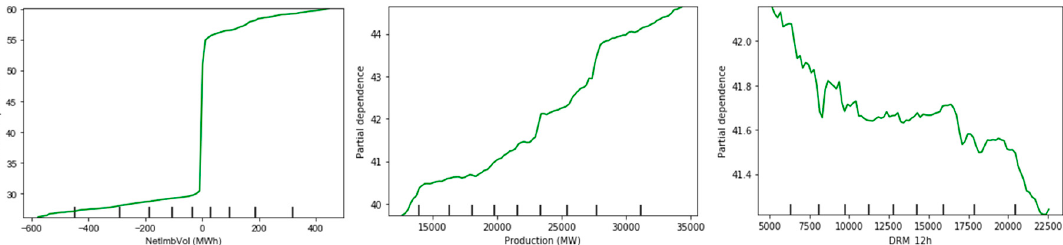
Figure 6. Partial dependency from the NetImbVol ( left ), Production ( center ) and DRM_12 h predictors